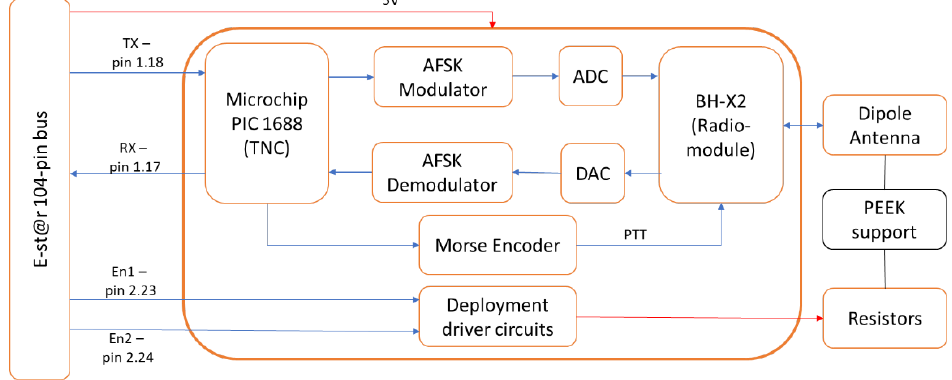
Figure 4. Communication systems (COMSYS) block diagram.